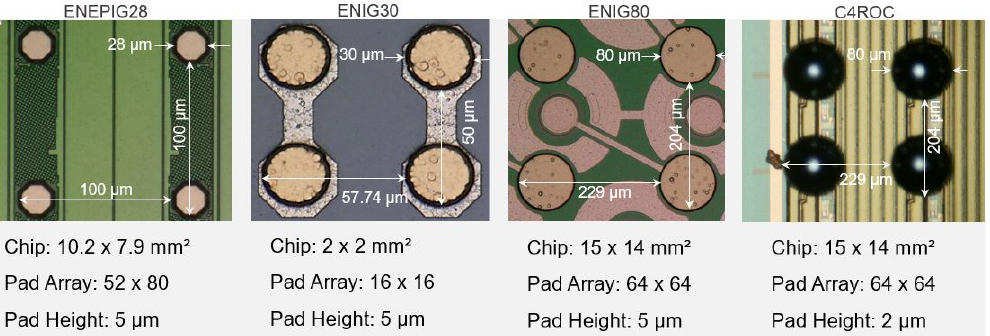
Figure 1. Micro photographs showing regions of four contacts of samples with Cu UBM.